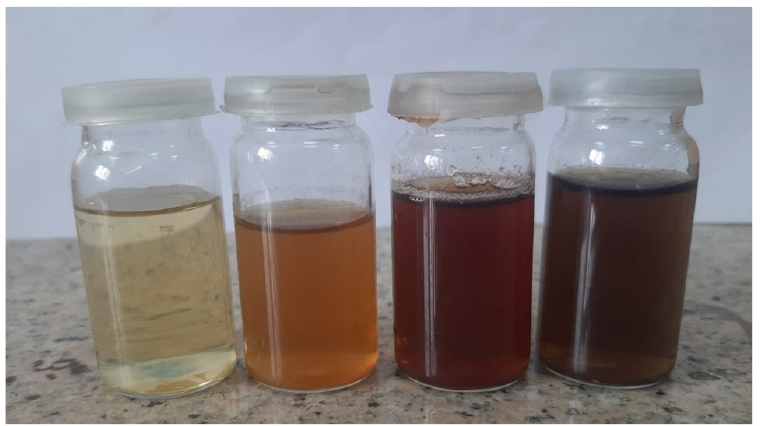
Figure 2. Green synthesised copper nanoparticles and colour change with an increase in the reduction